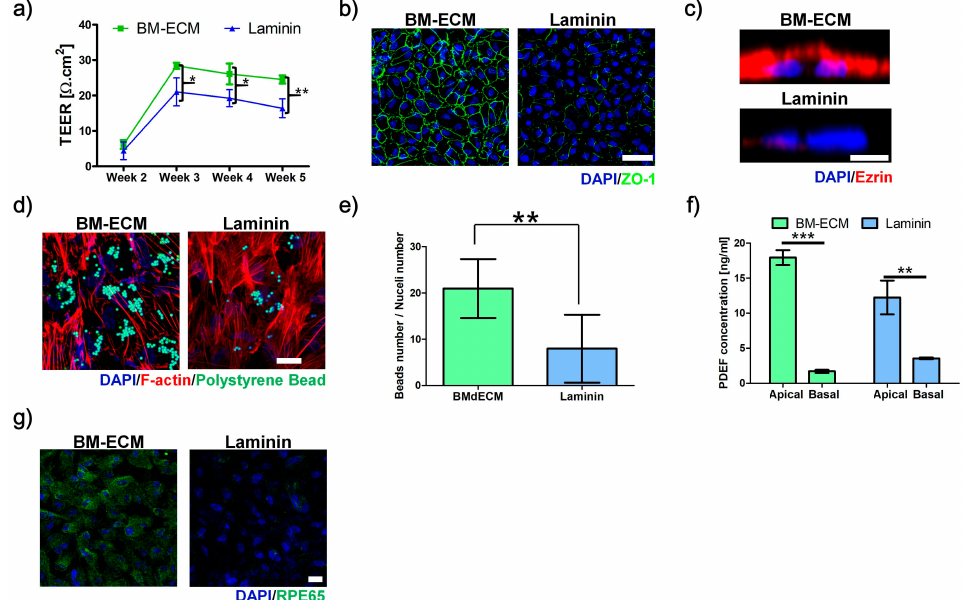
Figure 2. Effect of Bruch’s membrane-derived extracellular matrix bioink (BM-ECM) for retinal pigment epithelium (RPE) maturation. ( a ) Transepithelial electrical resistance (TEER) values at various times. ( b ) Expression of ZO-1 for tight junction, ( c ) Ezrin for microvilli formation, and ( d ) digested polystyrene beads for phagocytosis activity. ( e ) Ratios of digested beads numbers to nucleus numbers. ( f ) Secretion of pigment epithelium-derived factor (PEDF) in apical and basal medium for polarized PEDF secretion. ( g ) Expression of RPE65 for phototransduction in ARPE-19 cultured on BM-ECM- (BM-ECM) or laminin-coated Transwell (Laminin). Scale bar: ( b ) 50 µ m, ( c ) 5 µ m, ( d ), and ( g ) 20 µ m. The error bars represent the standard deviation. The data were compared using Student’s t-test and differences were considered significant when * for p < 0.05, ** for p < 0.01, and *** for p < 0.001 ( n =